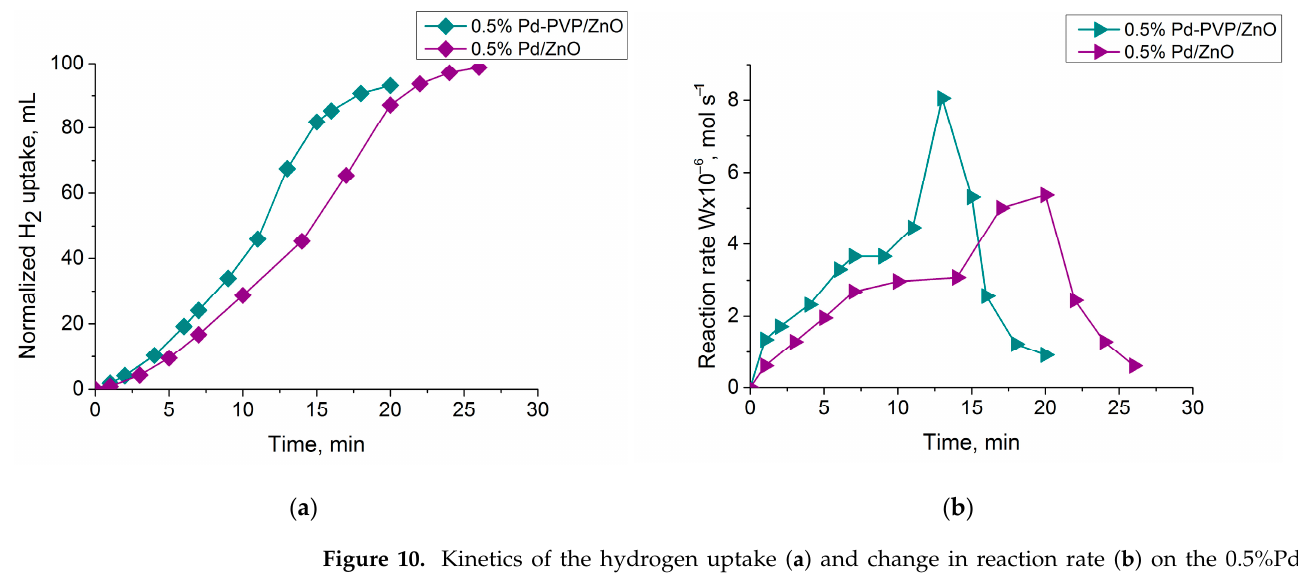
Figure 10. Kinetics of the hydrogen uptake ( a ) and change in reaction rate ( b ) on the 0.5%Pd-PVP/ZnO and 0.5%Pd/ZnO catalysts during the hydrogenation of 2-hexyn-1-ol to cis-2-hexen-1-ol, trans-2-hexen-1-ol and hexan-1-ol. Reaction conditions: T = 40 °C, P H2 = 1 atm, m cat = 0.05 g, solvent C 2 H 5 OH 0.25 mL, and C alkynol = 0.09 mol/L. According to chromatographic analysis, the maximum yield of cis-hexen-2-ol on the 0.5%Pd-PVP/ZnO catalyst is observed at the eleventh minute and is 87.2%, with 91.2% conversion of 2-hexyn-1-ol. This corresponds to 95.6% cis-alkene selectivity (Figure 11a).